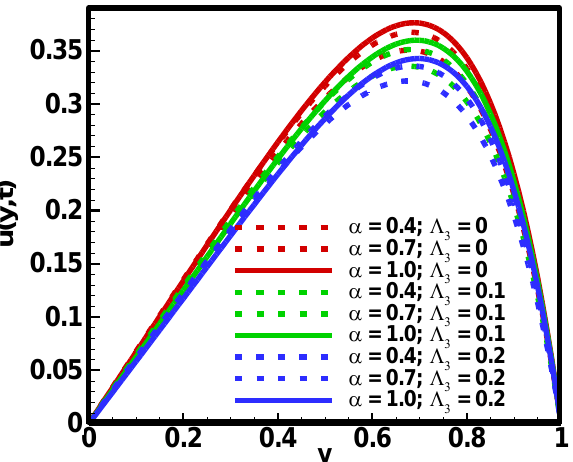
= 0.1, K = 0.1, Gr = 5, Ha = 5, 1 1